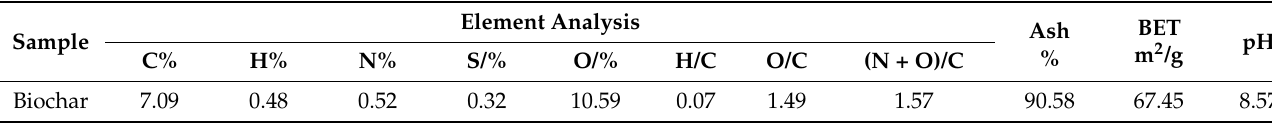
Table 1. Element analysis and property of the sludge